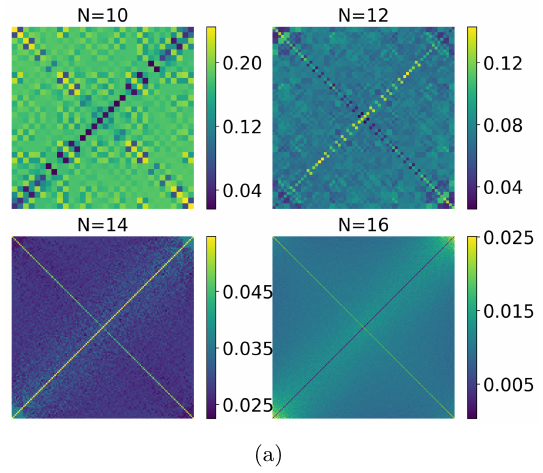
Figure 16 . The R mn matrices of the q = 3 SYK model with up to k = 3 -local operators taken to be easy. As one increases N , the overall R mn values are suppressed according to